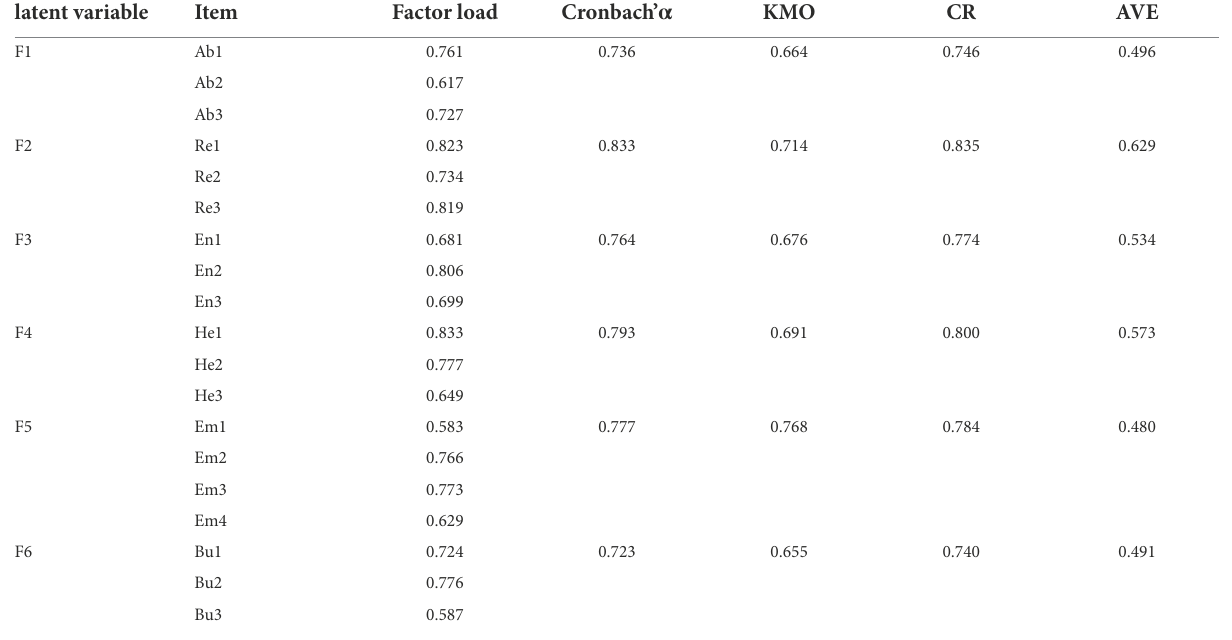
TABLE 3 Results of reliability and validity analysis. latent variable